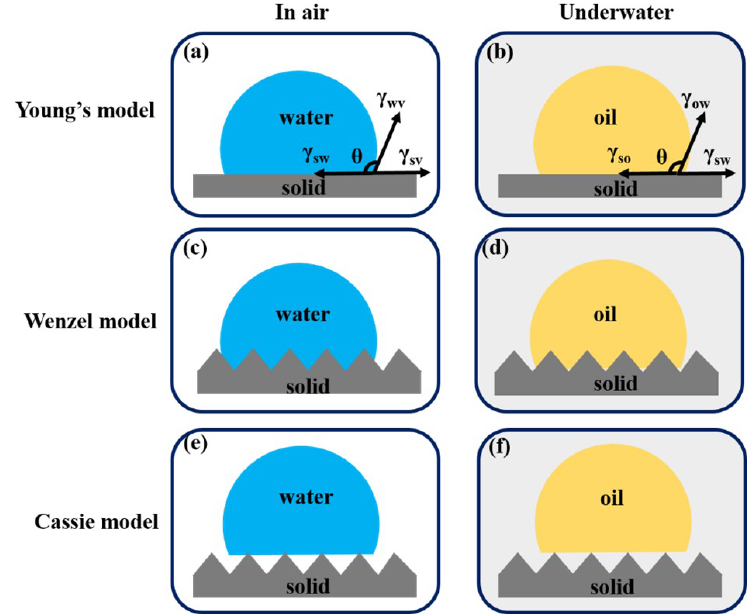
Figure 2. Schematic illustration of wetting mechanism. On the smooth surface ( a ) water droplet in air, and ( b ) oil droplets underwater. On the rough surface with the Wenzel state ( c ) water droplet in air, and ( d ) oil droplets underwater. On the rough surface with the Cassie-Baxter state ( e ) water droplet in air, and ( f ) oil droplets